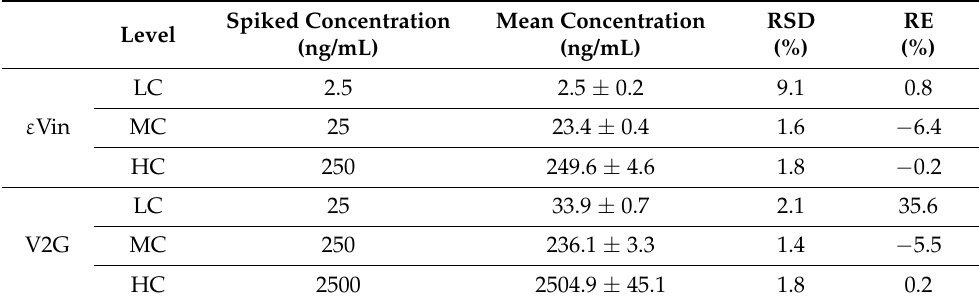
Table 1. Intraday precision of ε Vin and V2G in rat plasma ( n = 5). Spiked Concentration Level (ng/mL)